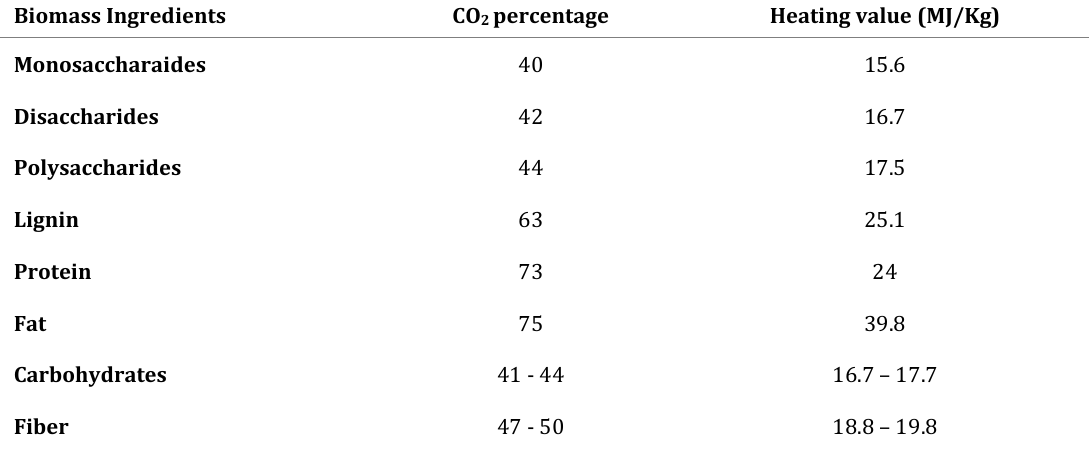
Table 1: Heating value of biomass ingredients Biomass Ingredients CO 2